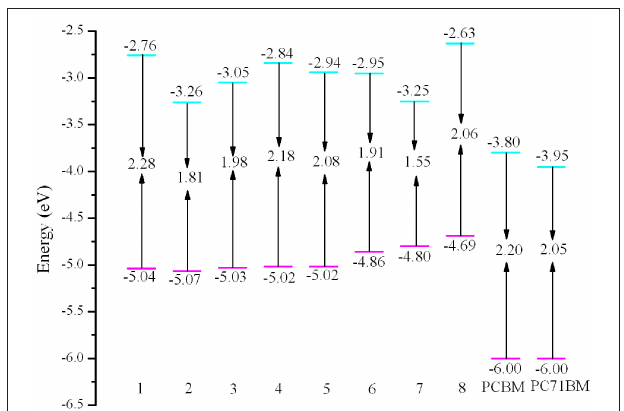
FIGURE 3 | Evaluation of calculated FMO energies for the designed molecules as well as FMO energies for PCBM and PC70BM at the PBE0/6-31G(d,p)